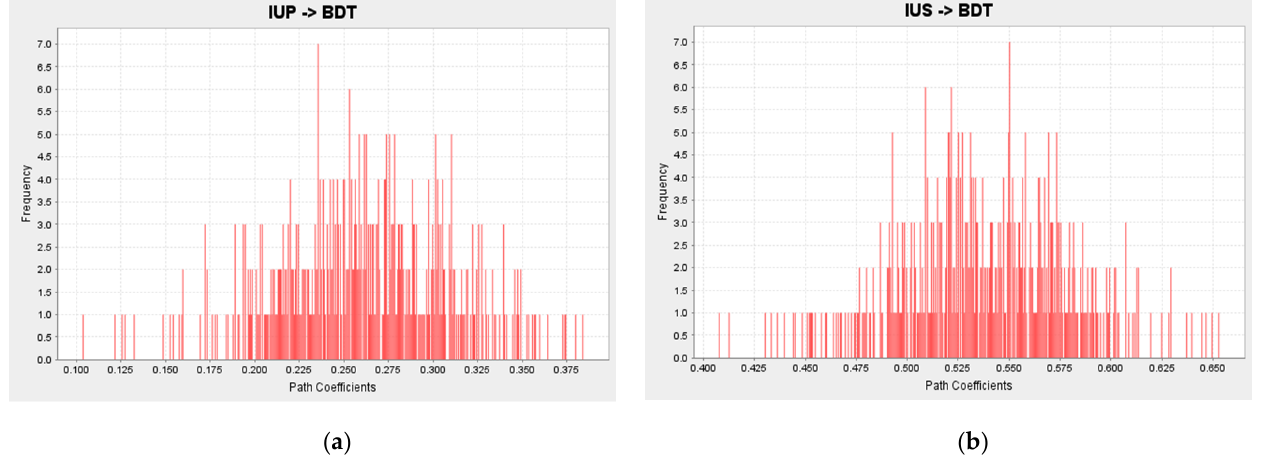
Figure 3. ( a ) Path coefficients IUP–BDT. ( b ) Path coefficients IUS–BDT.